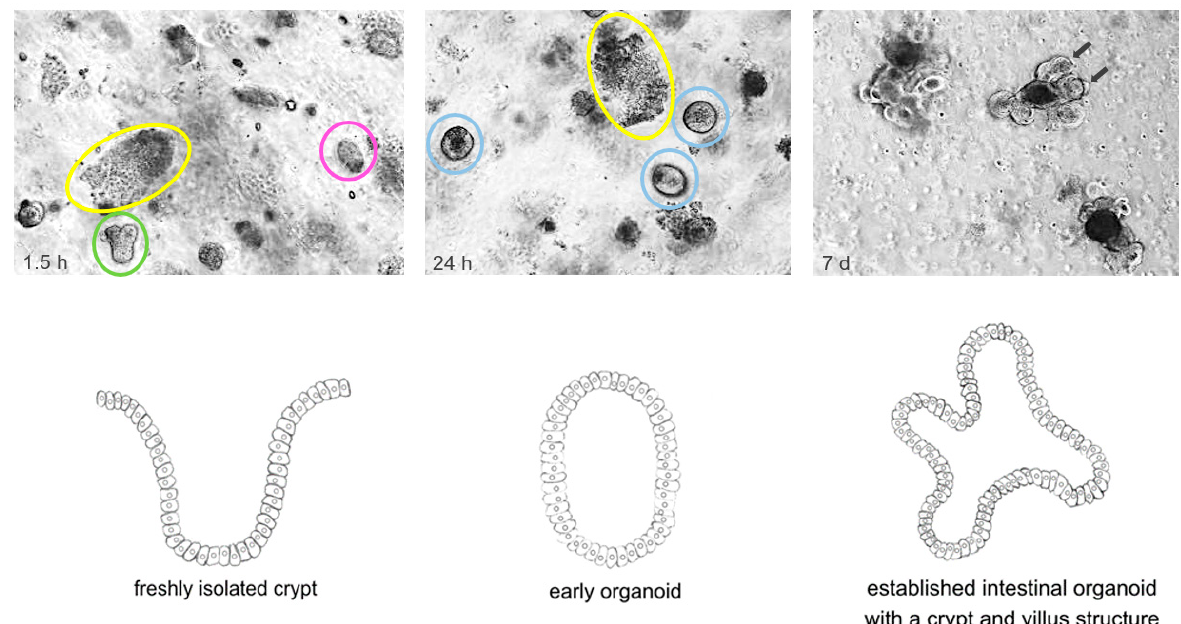
Figure 1. Time course of the isolation and establishment of murine wildtype intestinal organoids. Crypt isolation from surgical resected murine small intestine was carried out using EDTA and mechanical disruption according to initial description of Sato et al. [13]. The upper panel shows light microscopy pictures taken at indicated timepoints. The lower panel graphically illustrates the establishment of a murine intestinal organoid referring to the timepoints of the upper panel. Upper panel: Left: 1.5 h after isolation crypts (green) and villi (yellow) are embedded in Matrigel; some of the crypts have already closed (pink). Middle: 24 h after isolation the upper opening of crypts became sealed and early, round intestinal organoids (light blue) grew out. Villi (yellow) started to degrade. Right: 5–7 days after isolation, fully established intestinal organoids with a crypt (arrows) and villus structure can be found. Lower panel: Left: freshly isolated crypt. Middle: Early organoid structure after upper opening of crypts became sealed. Right: Fully established intestinal organoid with a crypt and villus structure.